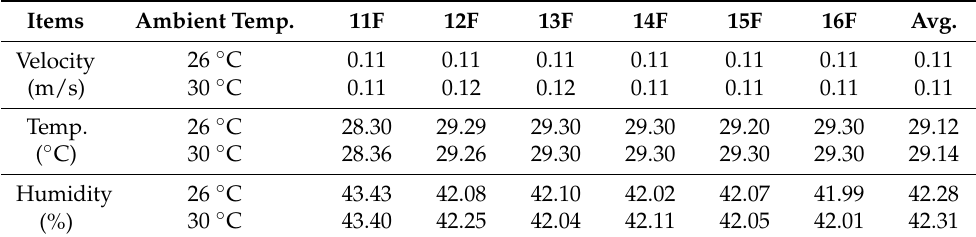
Figure 15. Temperature distribution with ambient temperature at 30 °C. Table 8. Thermal parameters at various ambient temperatures.